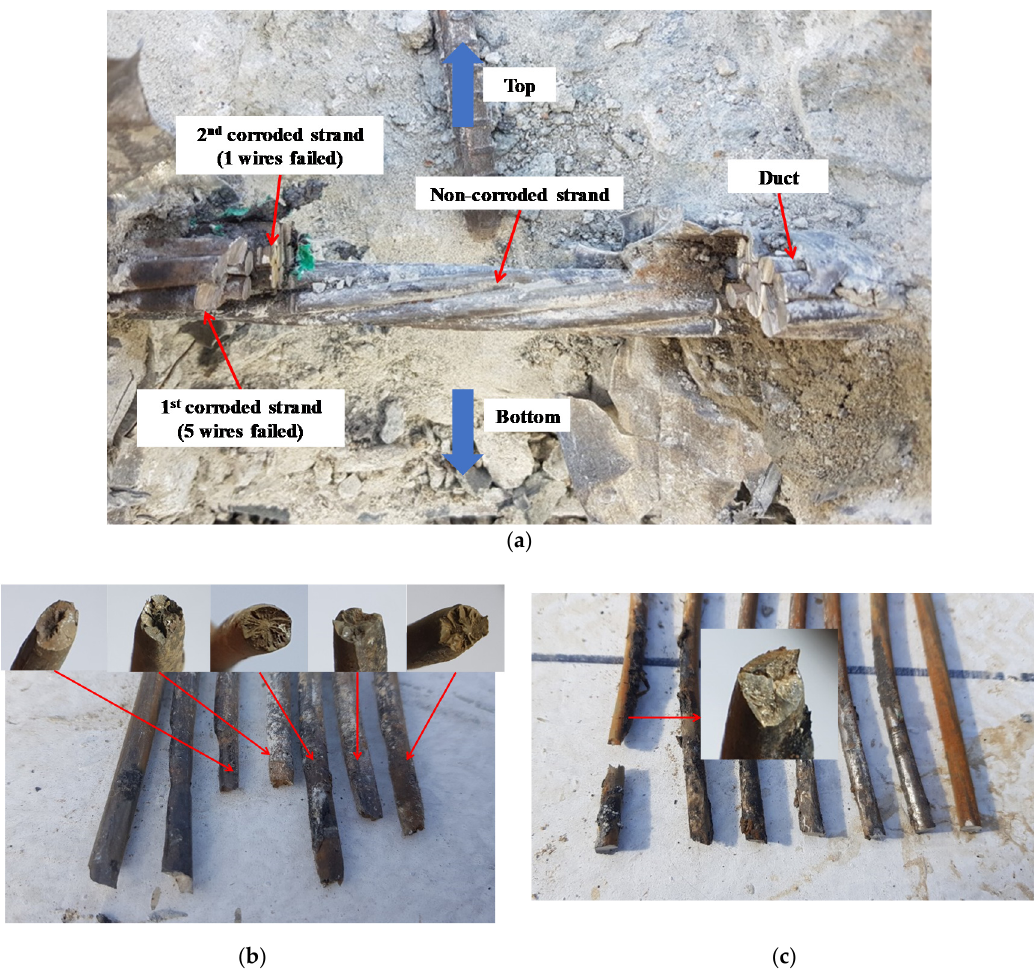
Figure 6. Deconstruction of CB1 after the loading test. ( a ) Side view, ( b ) failed section of 1st corroded strand, ( c ) failed section of 2nd corroded strand.